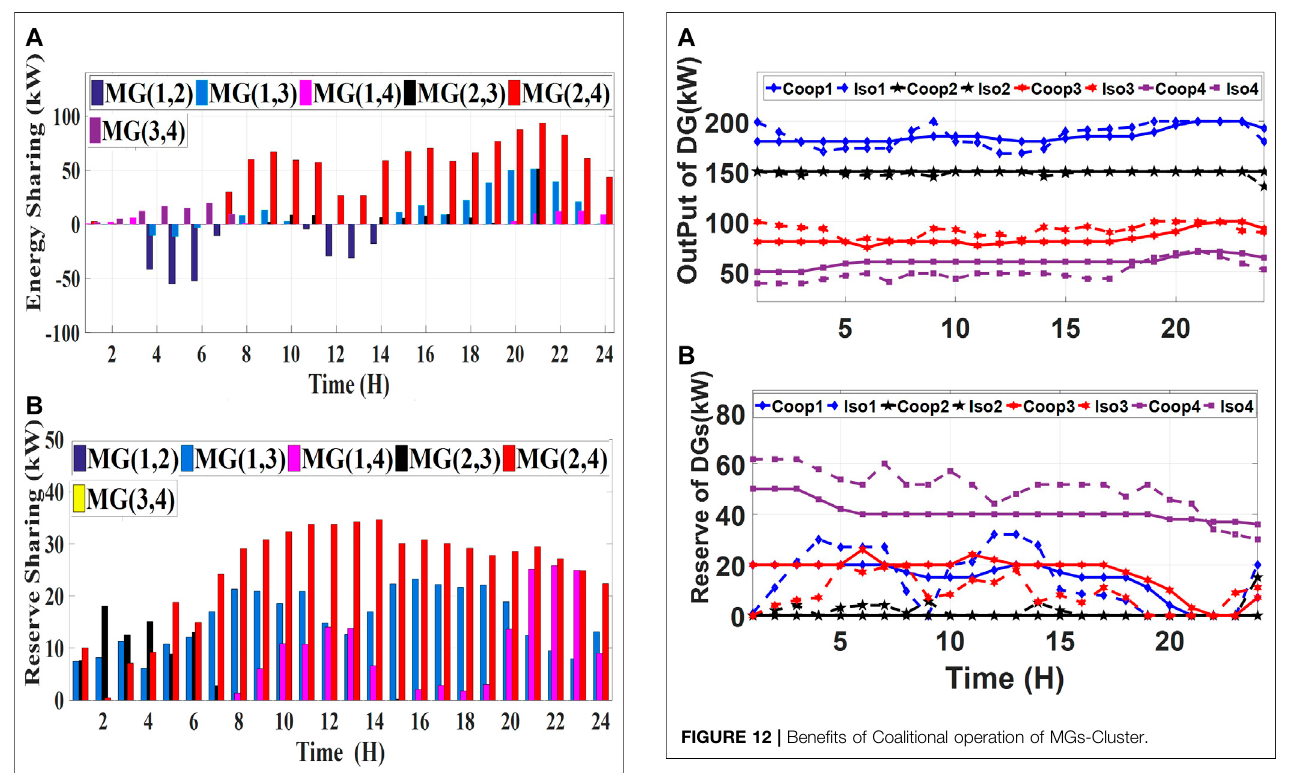
FIGURE 11 | Power exchange among MGs-Cluster